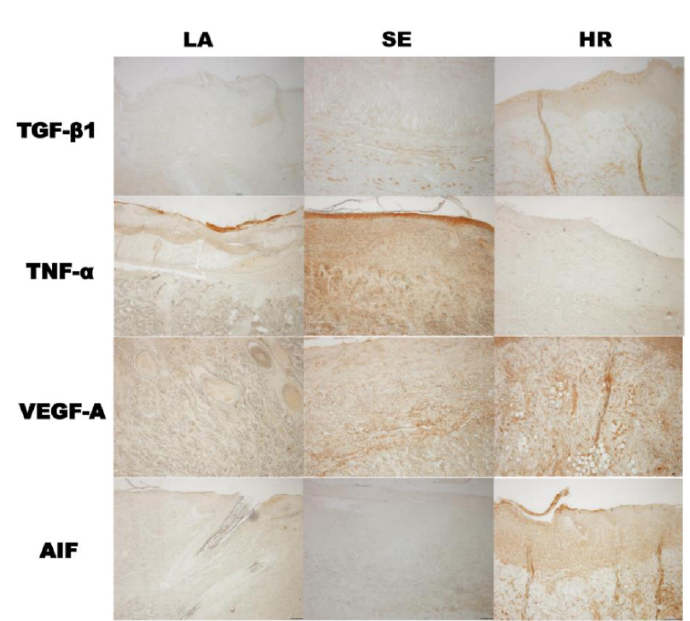
Figure 6. Immunohistochemical findings. The results of immunohistochemistry were also in accordance with those of tissue Western blot. TGF-β1 and AIF were highly expressed in the 4HR- administered group and TNF-α in the sericin group (LA: Lanolin ointment base only, SE: Sericin- group and TNF- α in the sericin group (LA: Lanolin ointment base only, SE: Sericin-administered group, administered group, HR: 4HR-administered group, original magnification × 100 without HR: 4HR-administered group, original magnification × 100 without counterstaining).